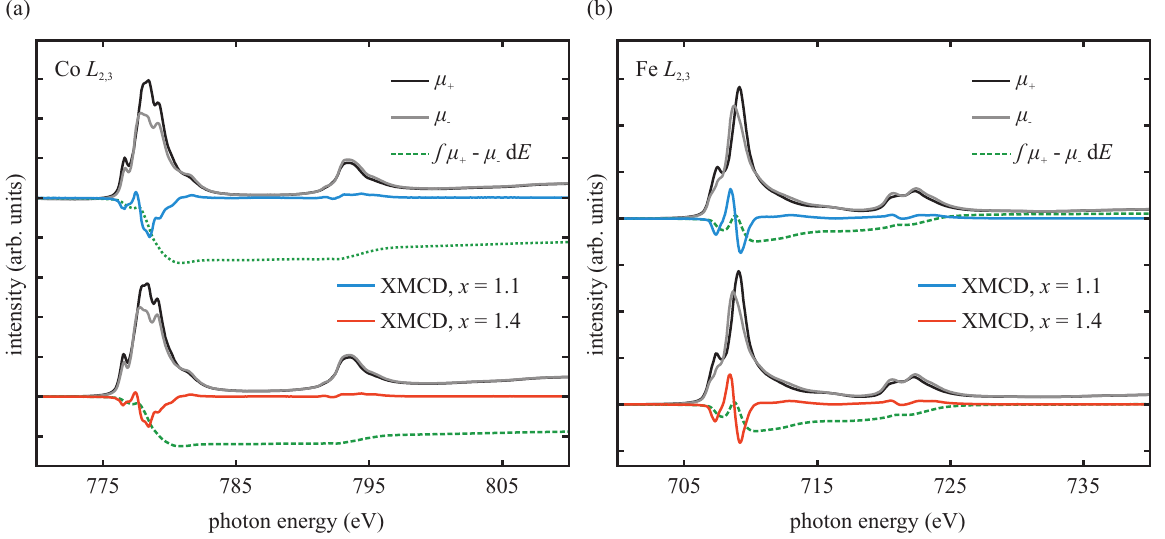
Figure 4. XMCD spectra (blue and red) and integrated XMCD spectra (dashed green) recorded at 300K across the ( a ) Co L 2,3 and ( b ) Fe L 2,3 edges of both samples. The spectra in gray ( µ + ) and black ( µ − ) are the absorption spectra recorded with two opposite directions of the external magnetic